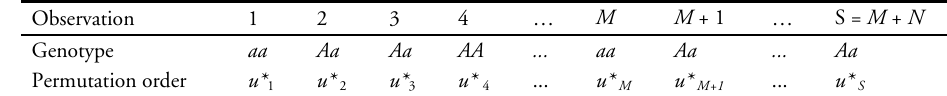
Figure 2 – Representation of the permuted data